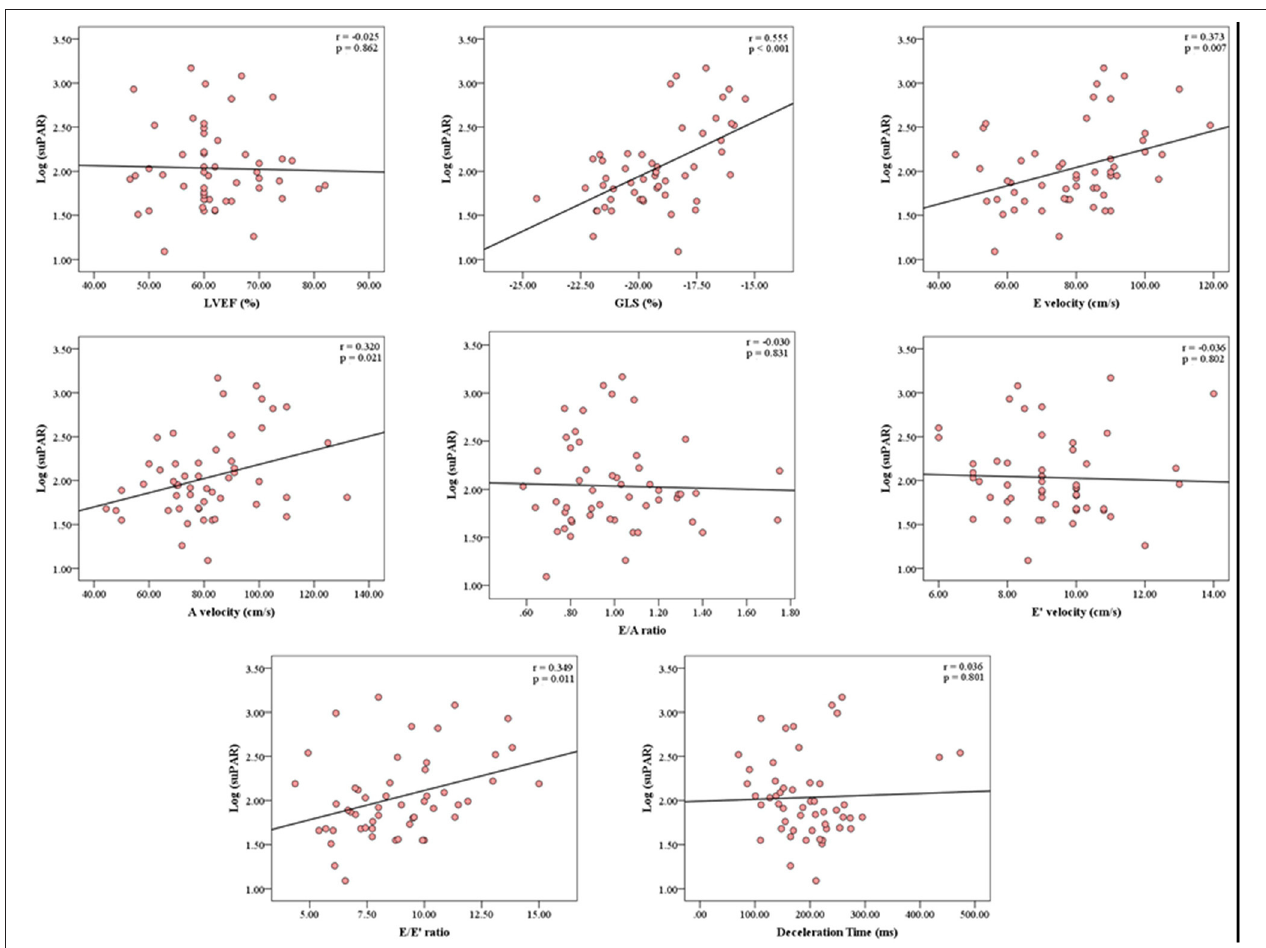
FIGURE 3 | Correlation Analysis between the serum concentration of suPAR and echocardiographic parameters. The correlation analysis graphs demonstrate significant correlations between suPAR levels and GLS, E velocity, A velocity, and E/E’. suPAR levels were not associated with LVEF. GLS, Global Longitudinal Strain; LVEF, Left Ventricular Ejection Fraction; r, Pearson’s correlation coefficient; suPAR, soluble urokinase-type Plasminogen Activator